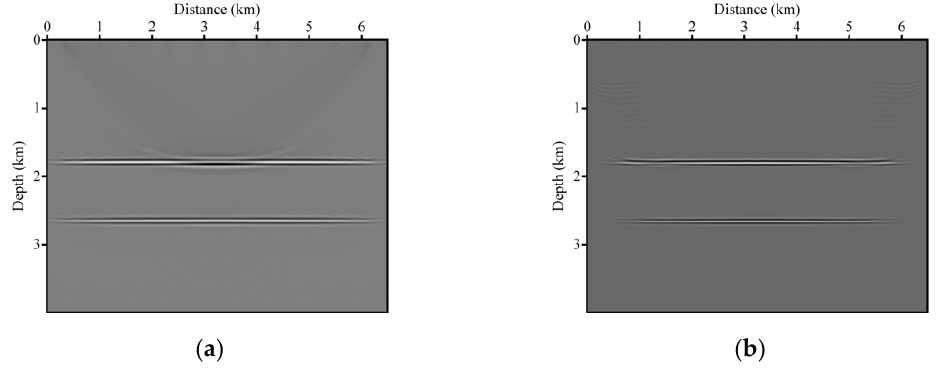
Figure 4. ERTM image obtained based on the VDWE: ( a ) PP imaging; ( b ) PS imaging.